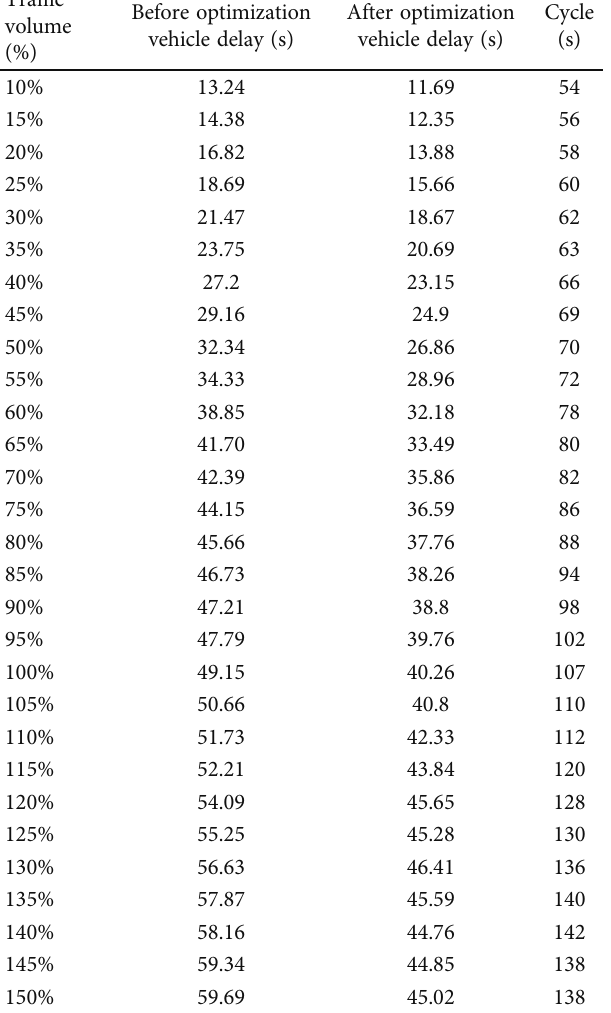
Table 10: The impact of tra ffi c volume on vehicle average delay and signal